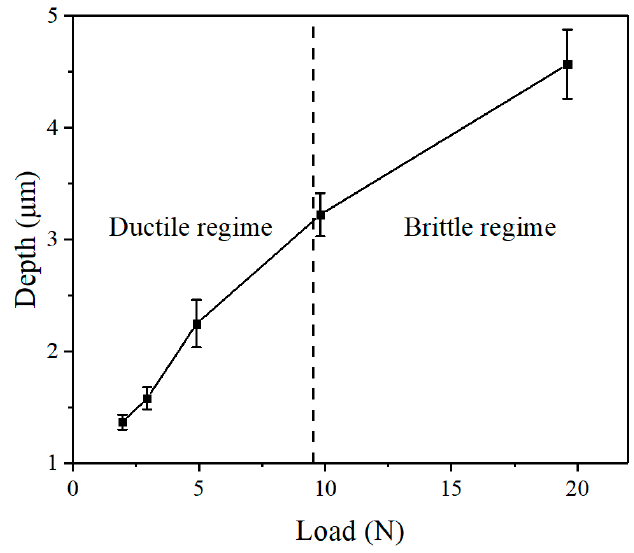
Figure 10. Relationship between the indentation depth and load.